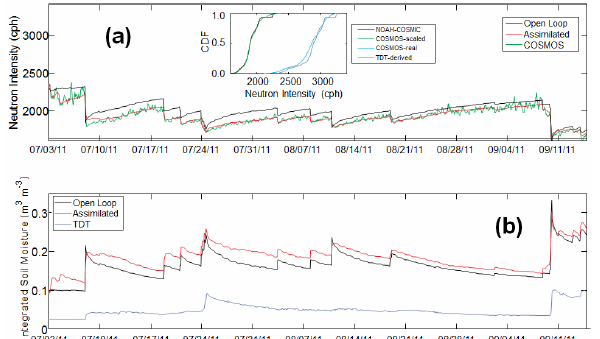
Fig. 10. Application of the COSMIC model to assimilate COSMOS probe counts into the Noah land surface model at the Santa Rita Range field site. (a) Time series of the observed neutron count (green) together with the neutron count (calculated by COSMIC) from the soil moisture profiles simulated by the recalibrated Noah model when running open loop (black) and with the assimilation of COSMOS data (red). (b) Depth-average soil moisture for the Noah model when running open loop (black) and with the assimilation of COSMOS data (red), together with the area-average soil moisture measured by the TDT network (purple). To enhance consistency between these three depth averages they are all weighted by the relative contribution to the above ground fast neutron flux for each level (calculated by COSMIC).